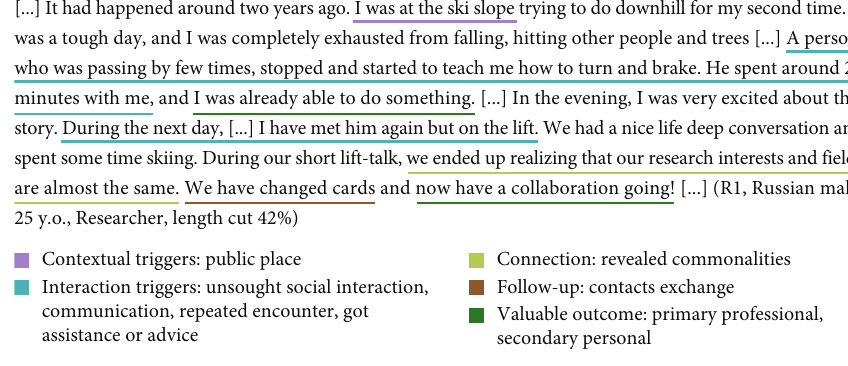
Figure 4: An excerpt from a respondent’s story of a chance encounter during leisure activities that led to professional collaboration. Being part of three [anonymized organization] projects, I spent quite much time on their premises. […] So